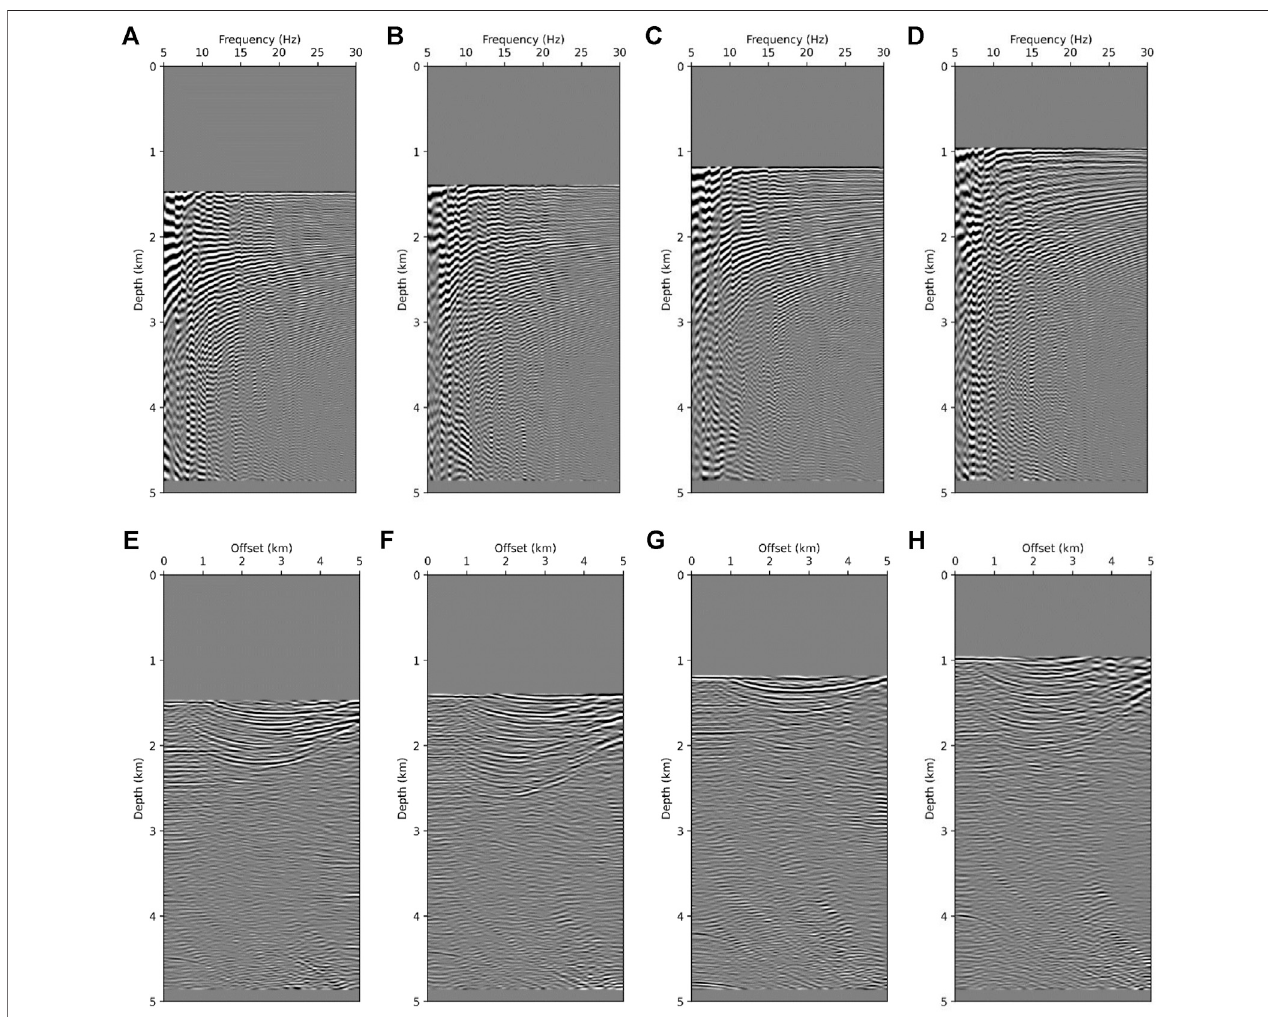
FIGURE 12 | Four FDCIGs of homogeneous velocity model at (A) 6.25 km, (B) 10 km, (C) 17.5 km, and (D) 23.75 km. Four ODCIGs of same model as that of FDCIGs at (E) 6.25 km, (F) 10 km, (G) 17.5 km, and (H) 23.75 km.